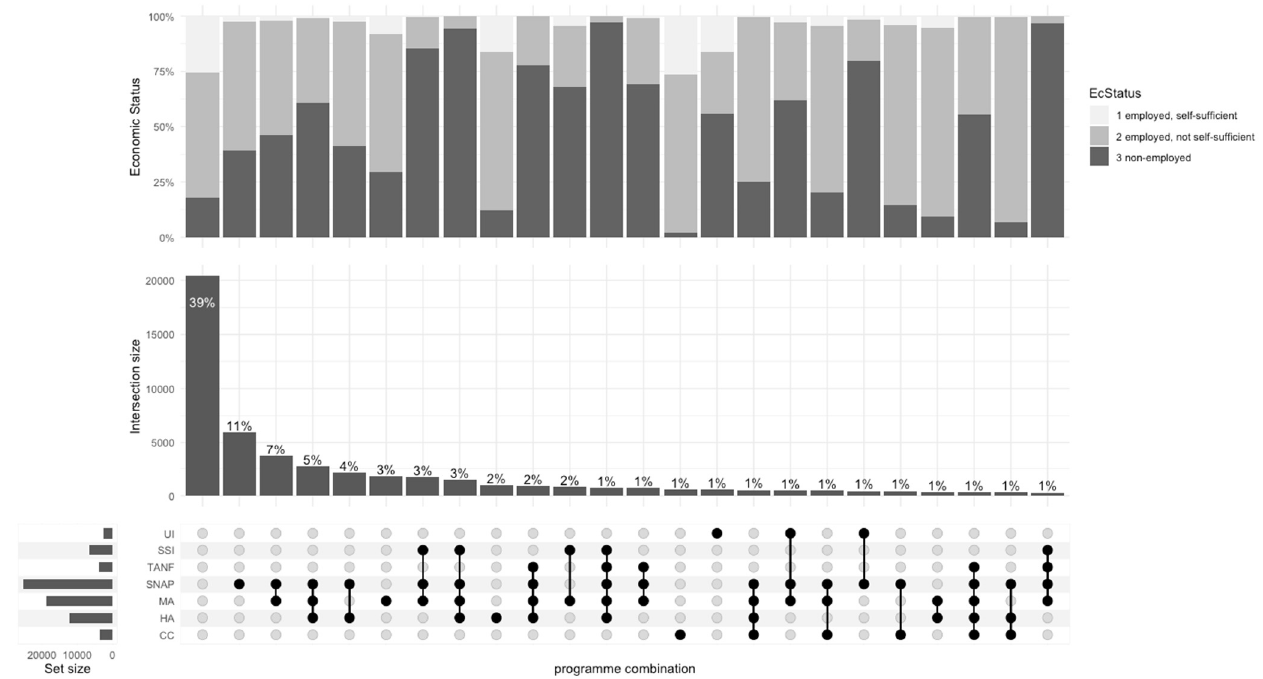
Figure 1. Patterns of Monthly Family Benefit Packages. Notes. 1. The descriptive statistics are based on 52,220 monthly observations. 2. Due to space limitation, 63 combinations of less than 1% of the observations (totaling 5%) are not shown in the figure (available upon request). 3. The circles in the matrix indicate programs that are part of the family benefit packages.